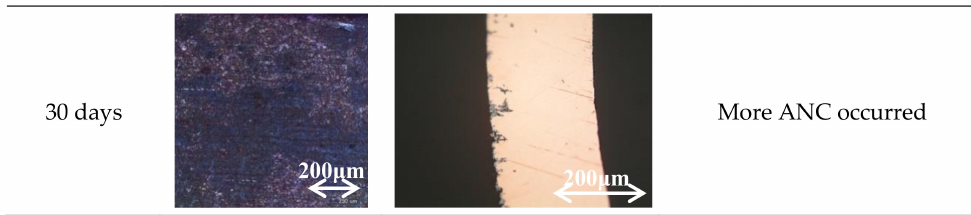
Figure 3. Surface and cross-section observations of Cu tube specimen immersed in 10 3 ppm Cu(HCOO) 2 with solution pH 3.